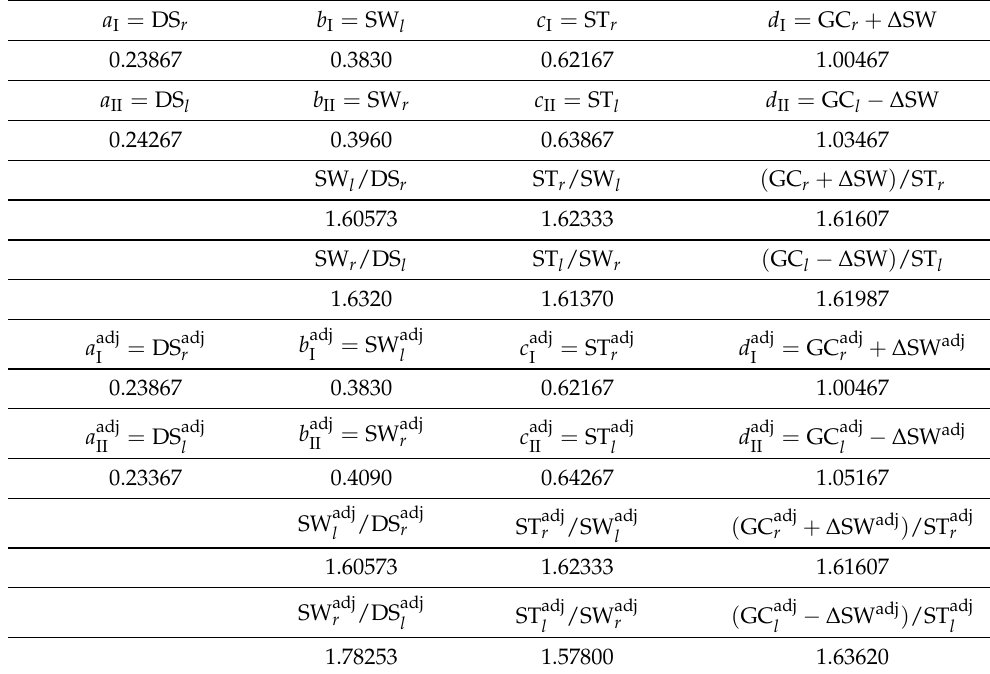
Table 6. Experimental data concerning the elements (in seconds) of the sequences I and II in (3) and their adjoint versions I adj , II adj in (4) for the healthy subject 3 (DS x = 0.11733 s, DS y = 0.12133 s).